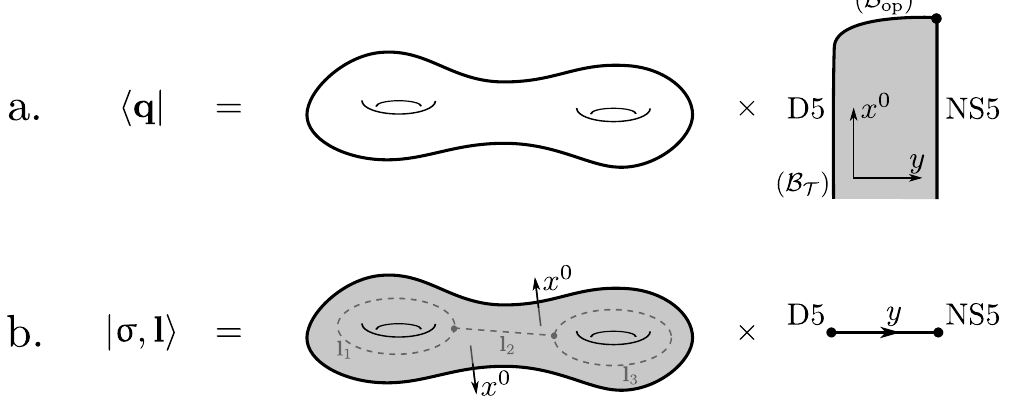
Figure 10 . (a) The state h q j is generated on the boundary C (cid:2) I of C times a brane corner. (b) The state j (cid:27) ; l i is created on the boundary C (cid:2) I of the solid handlebody C (cid:27) ; l times the interval I . The time direction x 0 is the outgoing normal vector at the boundary of the